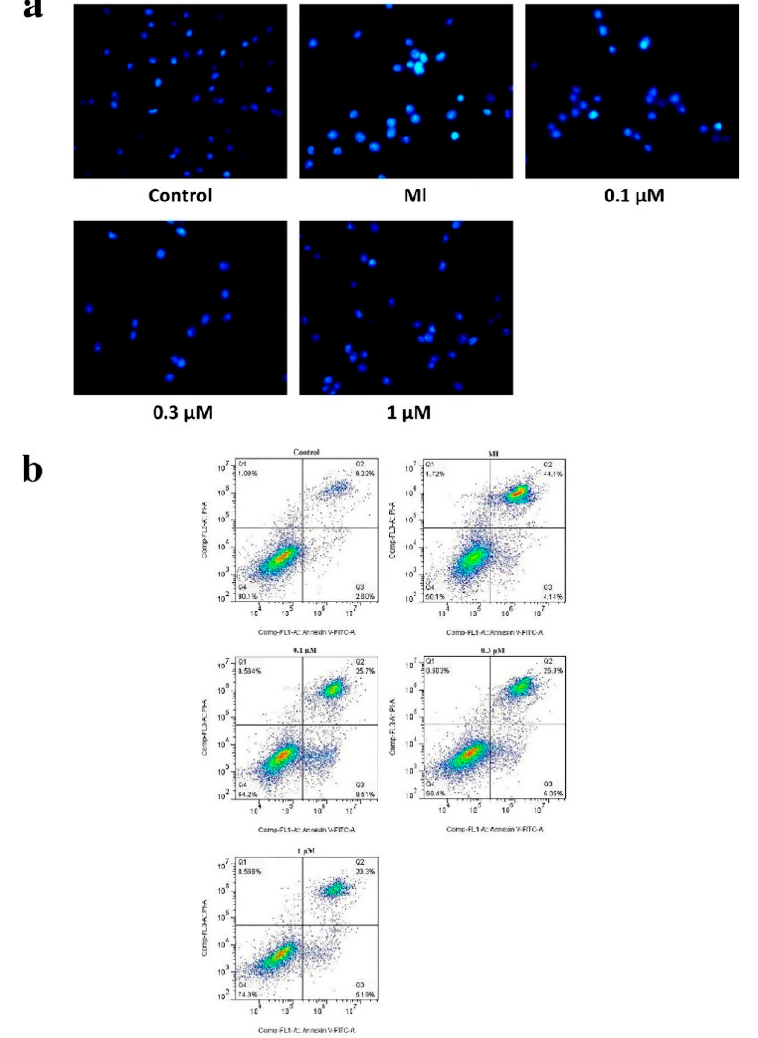
Figure 2. ( a ) Hoechst 33258 nuclear staining followed by fluorescence imaging was used to detect cell apoptosis. Fluorescence photomicrographs of cells stained with Hoechst 33258 ( × 400). ( b ) Anti- apoptotic effect of MTC on ischemic reperfusion induced PC12 injury confirmed by AnnexinV- FITC/PI.MTC was treated 24 h after ischemia.